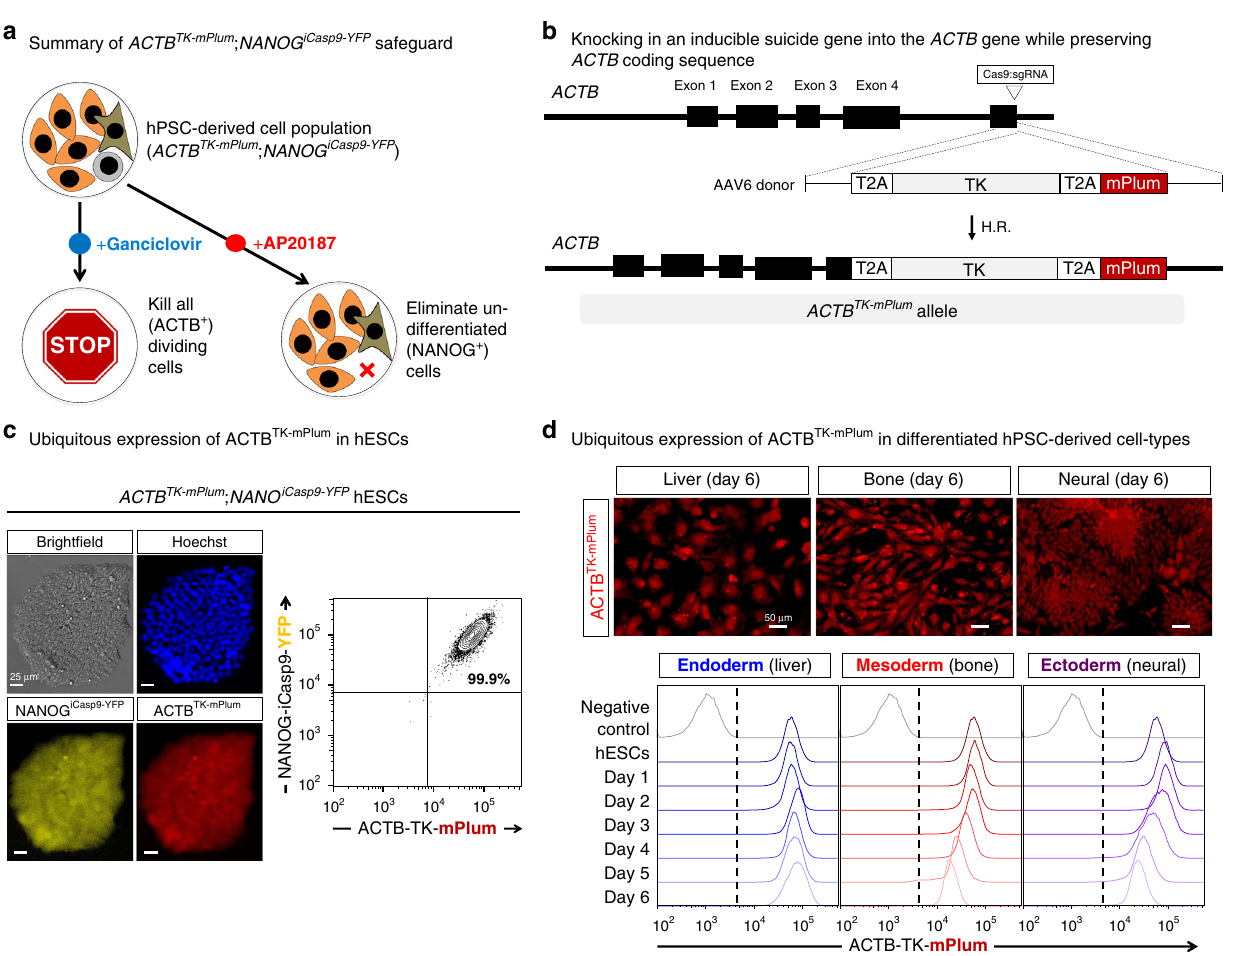
Fig. 4 Rationale and design of the ACTB TK-mPlum safety switch. a Intended application of the dual NANOG iCasp9-YFP ; ACTB TK-mPlum safeguard. b Cas9 RNP/ AAV6-based knock-in strategy for ACTB TK-mPlum targeting 38 , which was performed in the NANOG iCasp9-YFP hESC line. c mPlum was highly expressed in undifferentiated NANOG iCasp9-YFP ; ACTB TK-mPlum hESCs, as shown by epi fl uorescence ( left ) and fl ow cytometry ( right ). Scale bar = 25 μ m. d NANOG iCasp9-YFP ; ACTB TK-mPlum hESCs were differentiated into day 6 liver, sclerotome, and neural progenitors with mPlum levels remaining high throughout each type of differentiation as shown by epi fl uorescence ( top , for day 6 progenitors) and fl ow cytometry ( bottom , each 24h of differentiation). Dotted line delineates negative versus positive cells, with the gate set on negative control (wild-type) hESCs. Scale bar = 50 μ